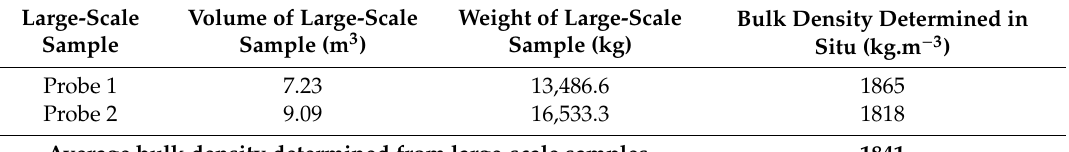
Table 6. Results of bulk density determination from large-scale samples in situ.